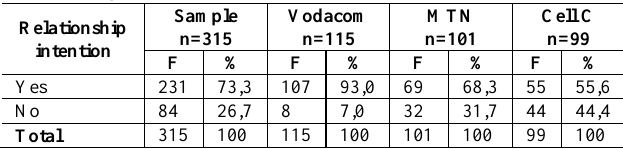
Table 2: Respondents’ relationship with their cell